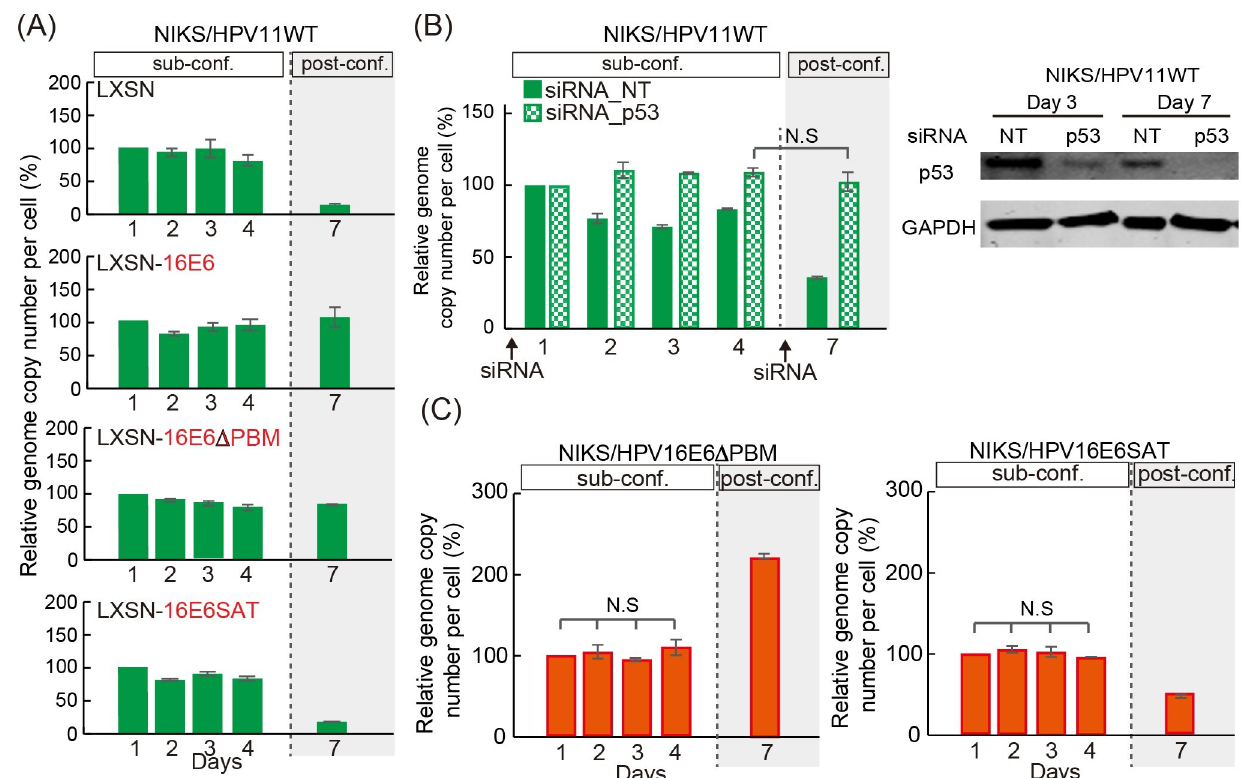
Fig 6. Inactivation of p53 rescues genome maintenance of low-risk HPV post-confluence. (A) The virus genome copy number per cell of HPV11 transfected NIKS or NIKS expressing 16E6, HPV16 E6 Δ PBM (16E6 Δ PBM) or HPV16 E6SAT (16E6SAT) was measured and prepared for presentation as outlined in Fig 1E. (B) The viral genome copy number per cell of HPV11 in NIKS transfected with siRNA (control (NT) or to p53) was carried out as in Fig 1E. Cells were collected at day 3 and 7 to establish p53 levels in the different cell populations (right). (C) The full genome of HPV16E6 Δ PBM (left) or HPV16E6SAT (right) was transfected into NIKS. The viral genome copy number per cell was measured and prepared for presentation as outlined in Fig 1E.